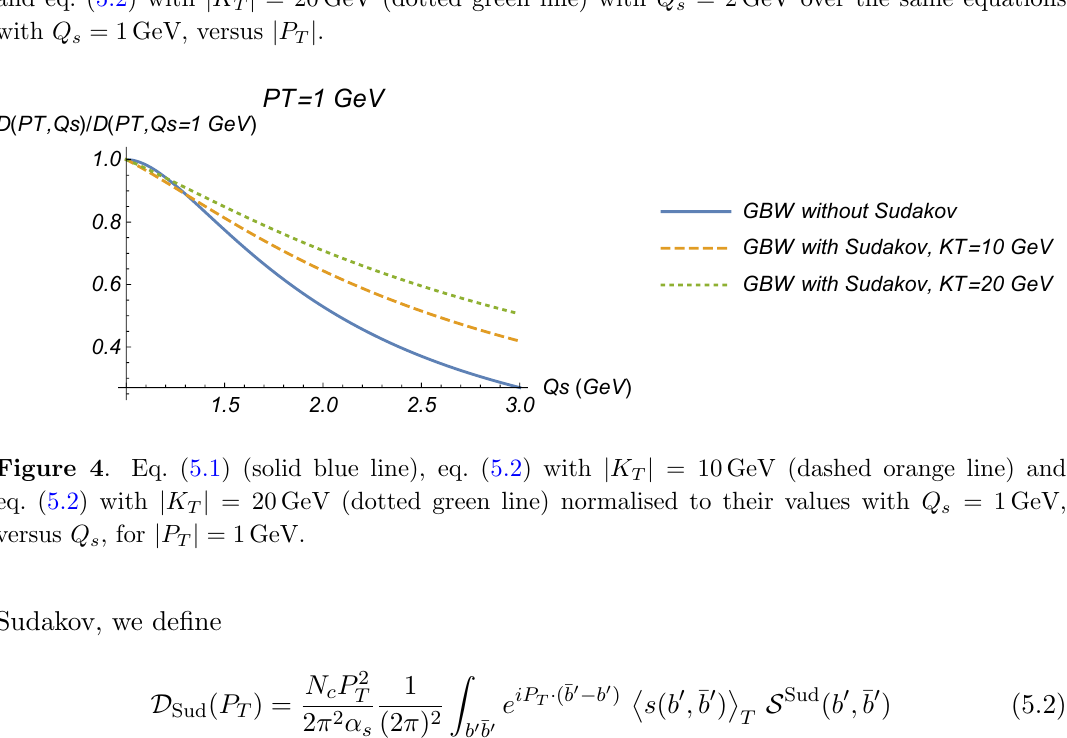
K T = 20 GeV (dotted green line) with Q s = 2 GeV over the same equations j j P T . j j